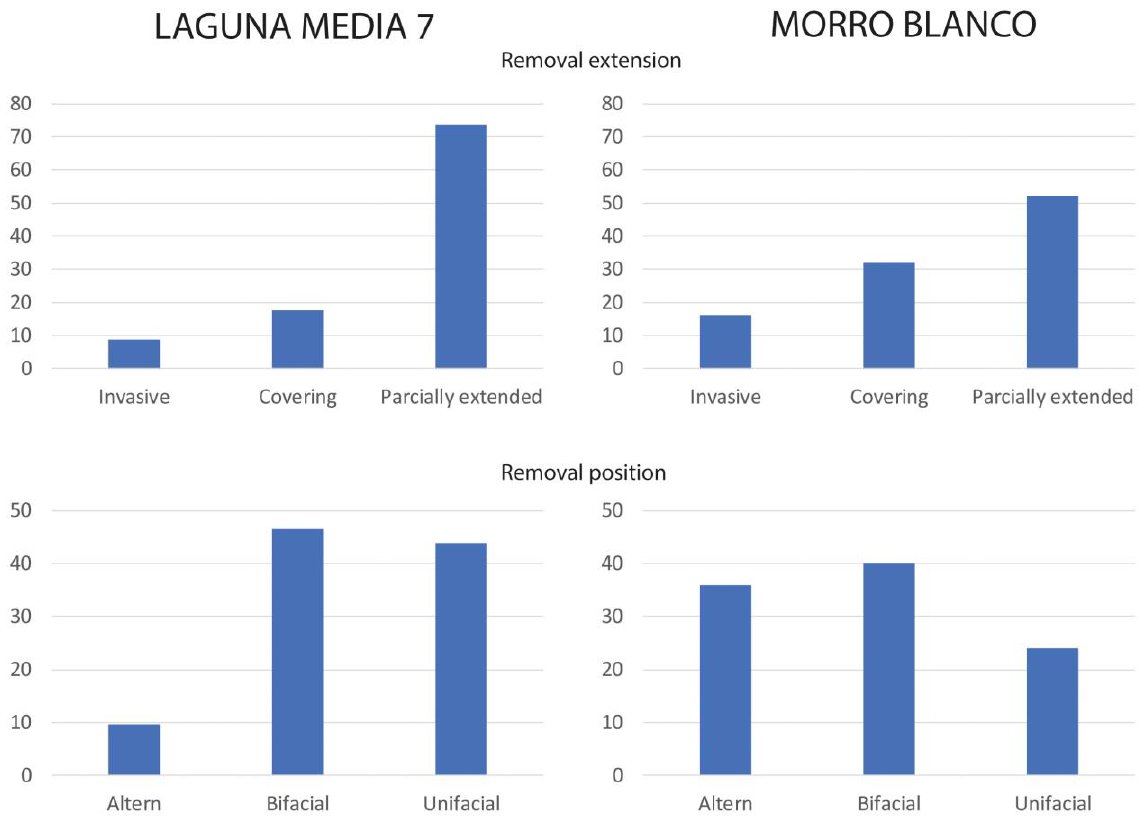
Figure 9. Distribution (percentages) of shaping methods on Laguna Media 7 and Morro